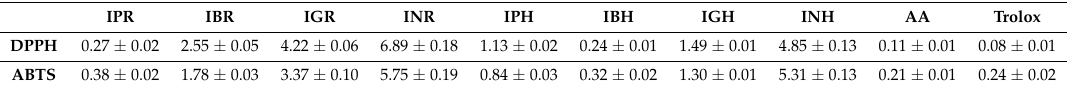
Table 2. The antioxidant activity—DPPH and free radicals scavenging ability (ABTS) of polysaccharide fractions of the Impatiens species. The results are expressed as EC 50 in mg/mL of DE (dry extract). Ascorbic acid (AA) and Trolox were used as the positive control. Each value is the mean ± SD ( n = 3). IPR IBR IGR INR IPH IBH IGH INH AA